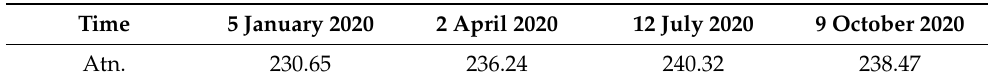
Table 2. The measured attenuation of the electric field (dB) in different seasons (the elevation angles of the transmitting and receiving antennas are kept at 0 ◦